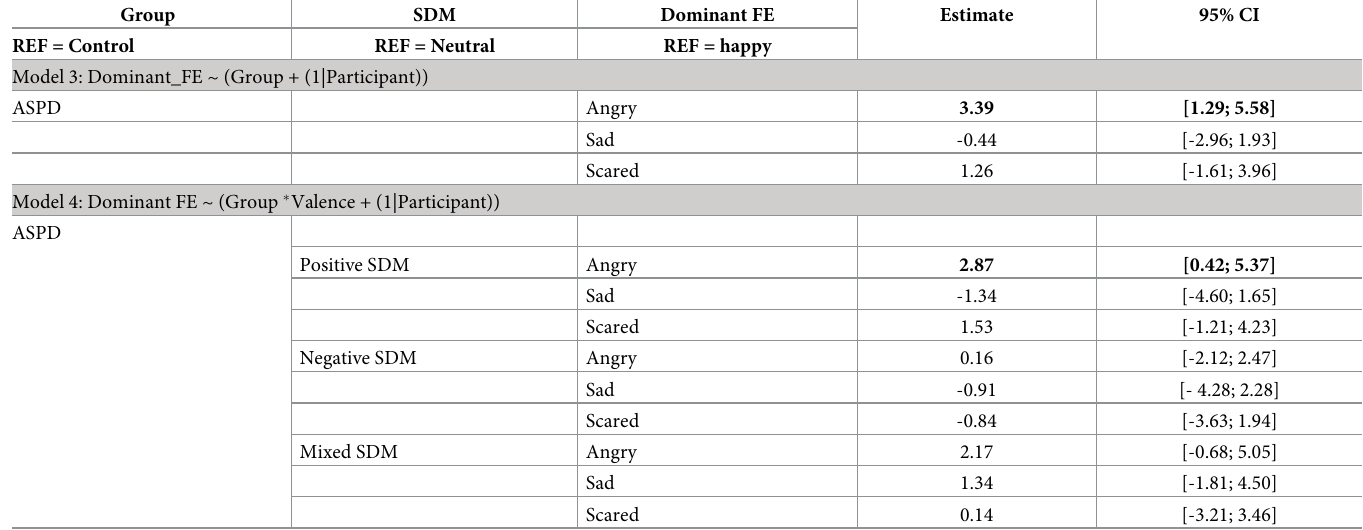
Table 1. Results of categorical logistic regression for main effects (Model 3) and interaction effects (Model 4) models for predicting dominant facial expression in ASPD and healthy control groups and valence of SDM.